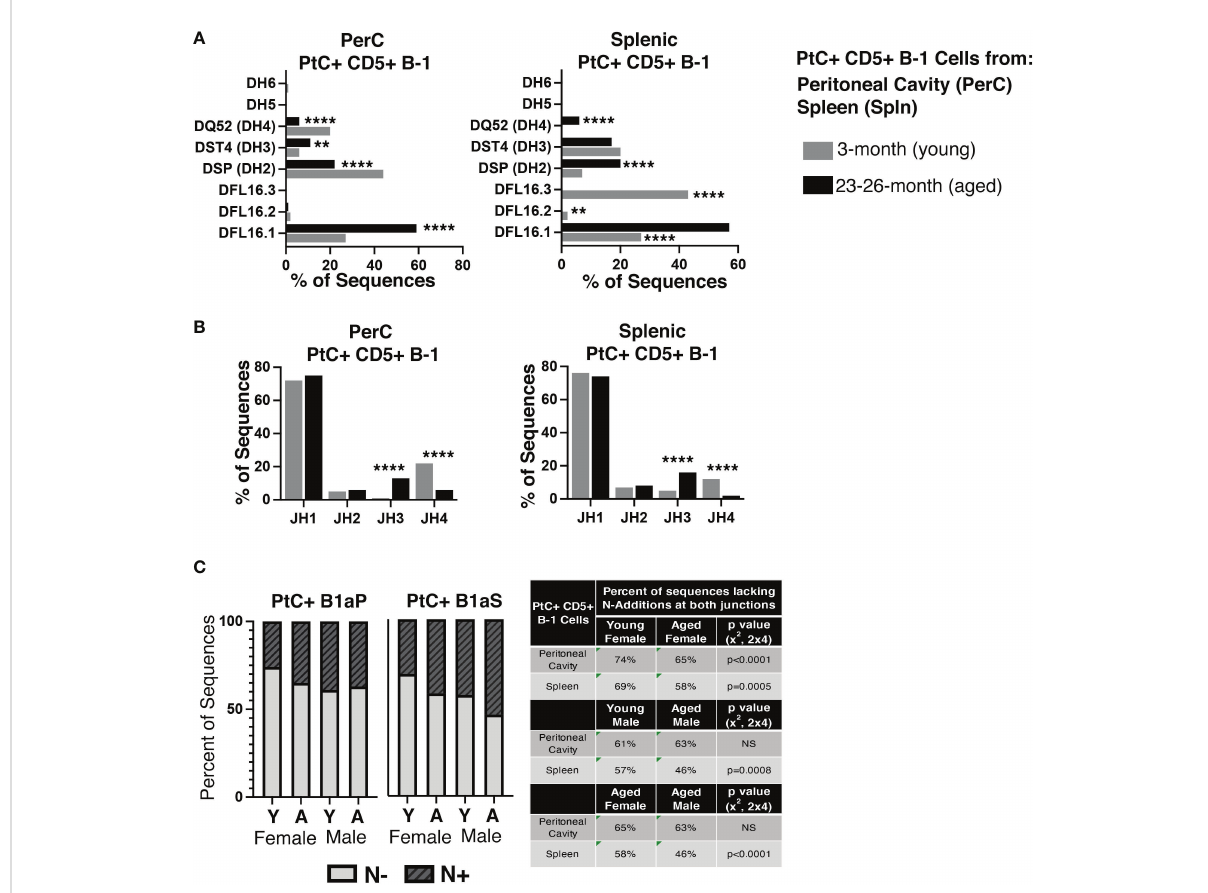
FIGURE 4 Analysis of D H use, J H use, and germline status of young and aged PtC+CD5+ B-1 cells. PtC+CD5+ B-1 cells were single-cell sorted from the peritoneal cavity or spleen of young and aged female BALB/c-ByJ mice (as presented in Figure 2). (A) The percent of D H gene segment usage. (B) The percent of J H gene segment usage. (C) The percent of sequences containing zero N-additions (light grey bars) or 1 or more N-additions (dark grey hashed bars) at both junctions is shown with replicate sequences included in the analysis. For direct comparison offemales and males, previously published (24) N- addition analysis of young and aged male PtC+ CD5+ B-1 cells is included. Results are based on 4 independent experiments with sequences combined fromeach independent experiment (n=11 for 3-month-old mice, n=15 for 23-26-month-old female